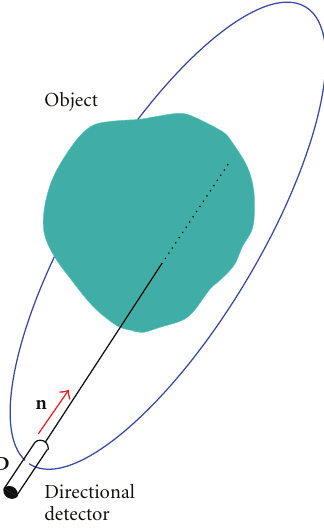
Figure 1: Linear projection through an